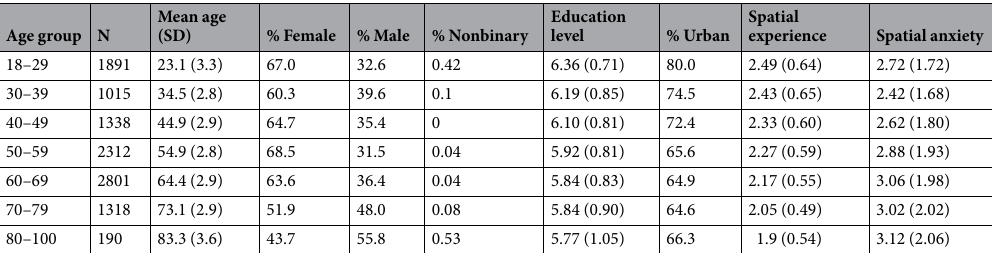
Table 2. Descriptive statistics of participants (age